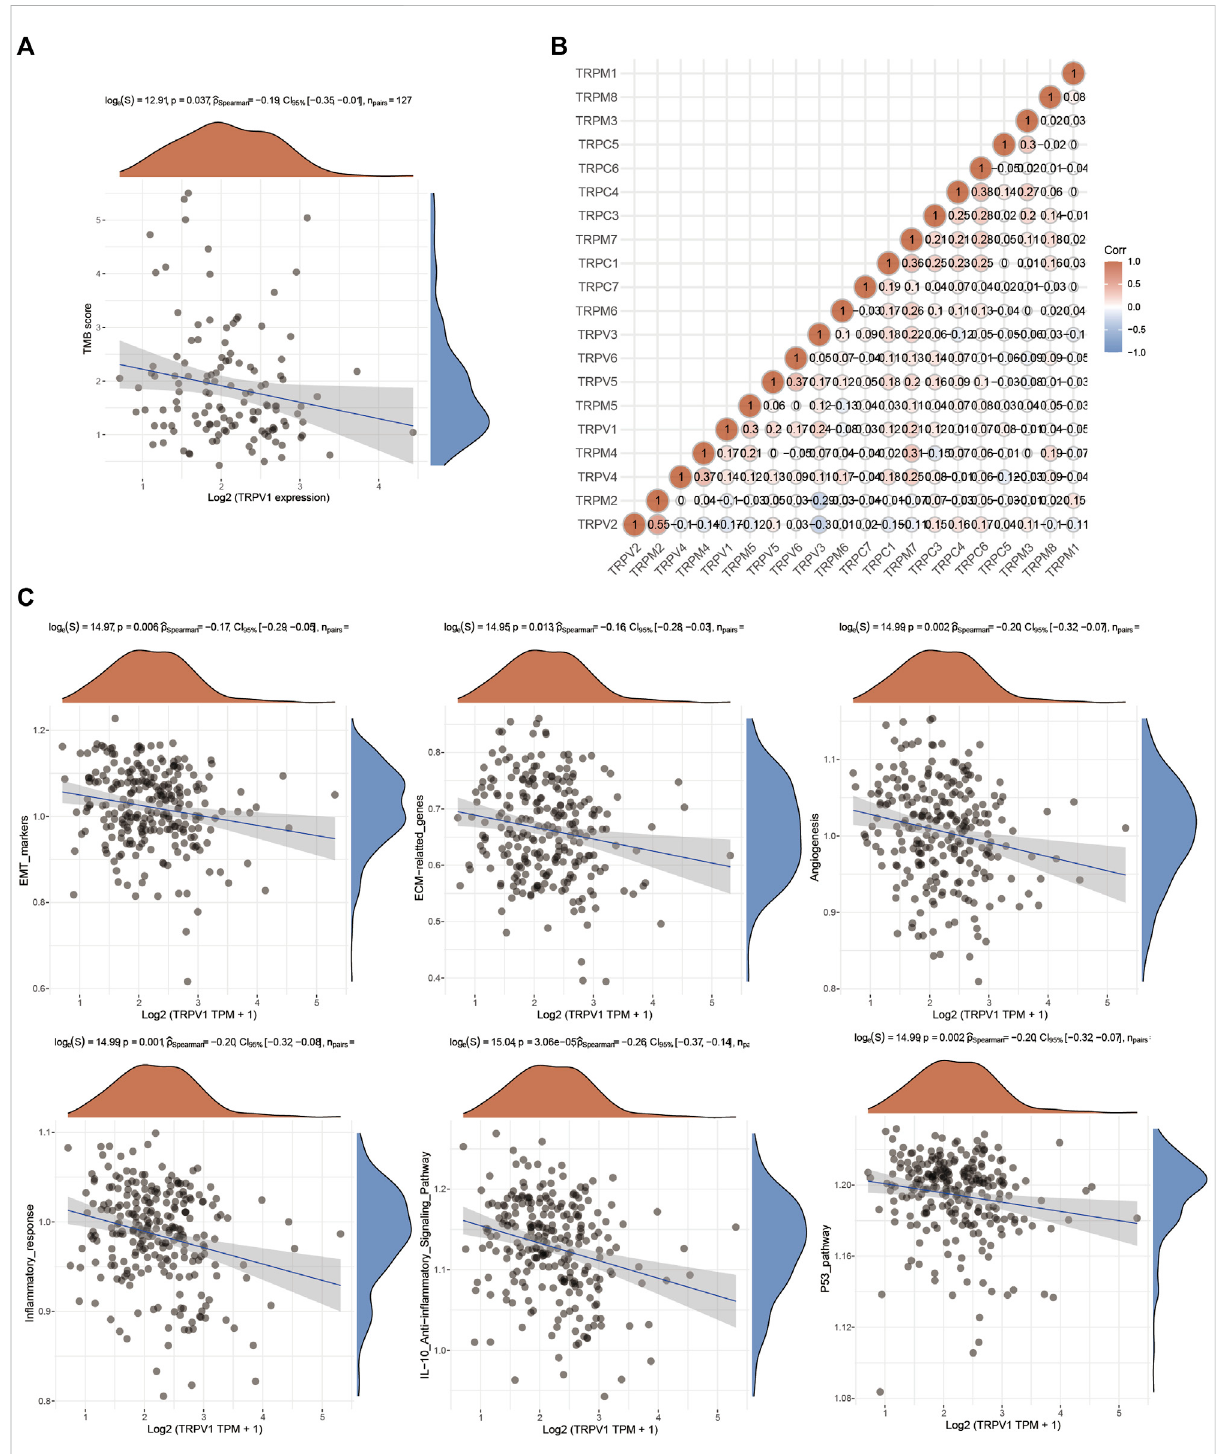
The function of TRPV1 in CSCC. (A) Correlation analysis between TRPV1 expression and TMB was performed using Spearmans method. The abscissa represents gene expression distribution, and the ordinate represents TMB score distribution. The density curve on the right represents the distribution trend of TMB score; the upper density curve represents the distribution trend of gene expression. The values on the top represents the correlation p value,correlationcoef fi cientandcorrelationcalculationmethod. (B) GenecorrelationanalysisofTRPsinCSCC. (C) Theregulatory mechanism of TRPV1 on signaling